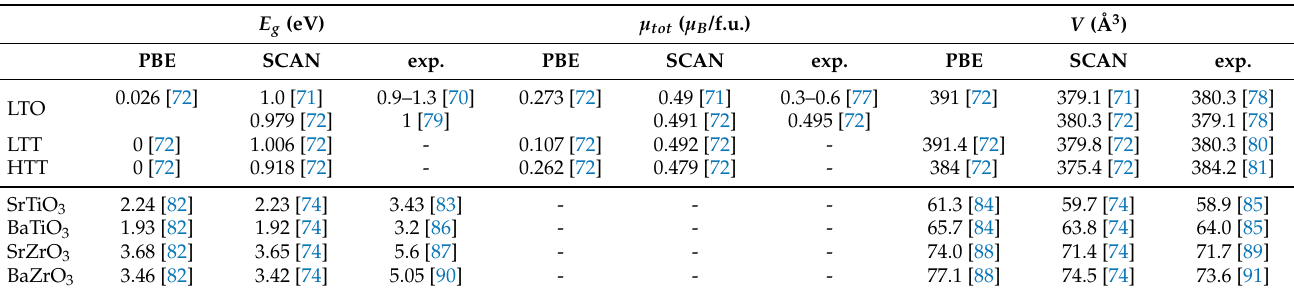
Table 1. The energy gap E g , total magnetic moment µ tot , and equlibrium volume cell calculated within PBE and SCAN for the La 2 CuO 4 and AB O 3 compounds. The experimental data are also